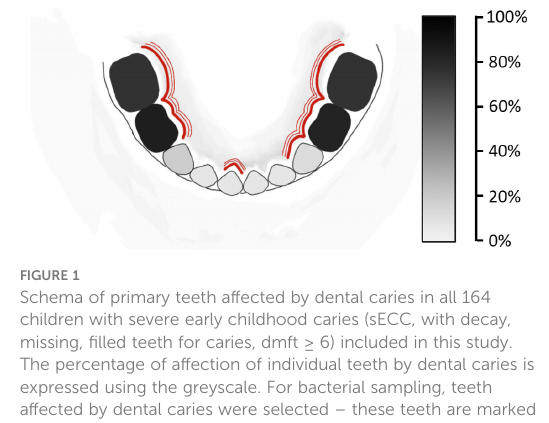
Table S1 . C. dubliniensis and S. mutans were signi fi cantly more common in the dental plaque of children who were breastfed for less than 6 months ( p < 0.05). Similarly, serving sweet beverages was associated with a higher frequency of the occurrence of Candida spp. and S. mutans ( p < 0.05, OR > 3, Supplementary Table S1 ). Initiation of regular teeth brushing after the 12 th month of child ’ s age was associated with a more common occurrence of these candidas ( p < 0.05), C. albicans was associated also with a lower frequency of teeth brushing ( p < 0.05, Supplementary Table S1 ).